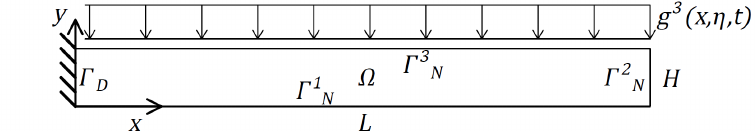
Figure 1. Schematic representation of the cantilever beam